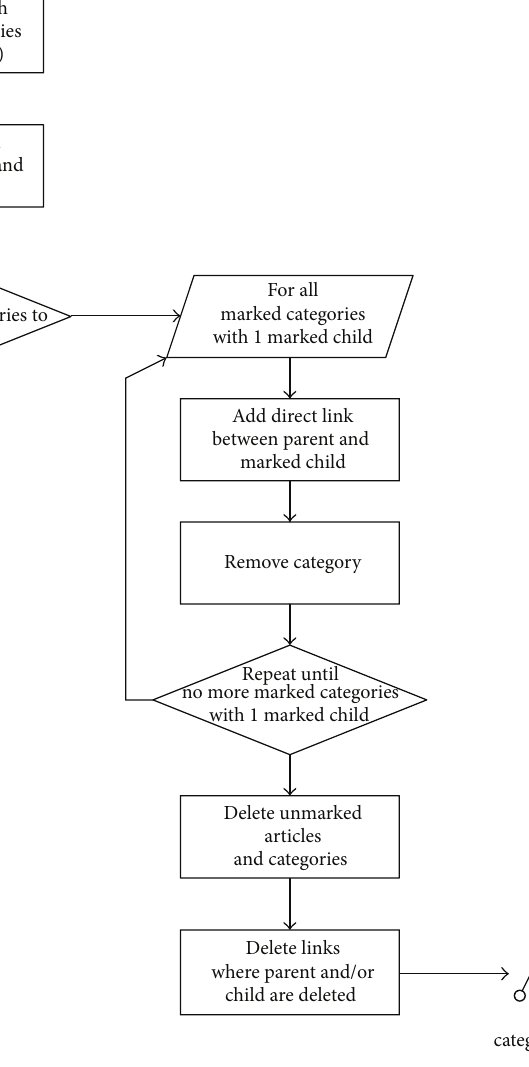
Figure 4: Flowchart for generating the pruned category